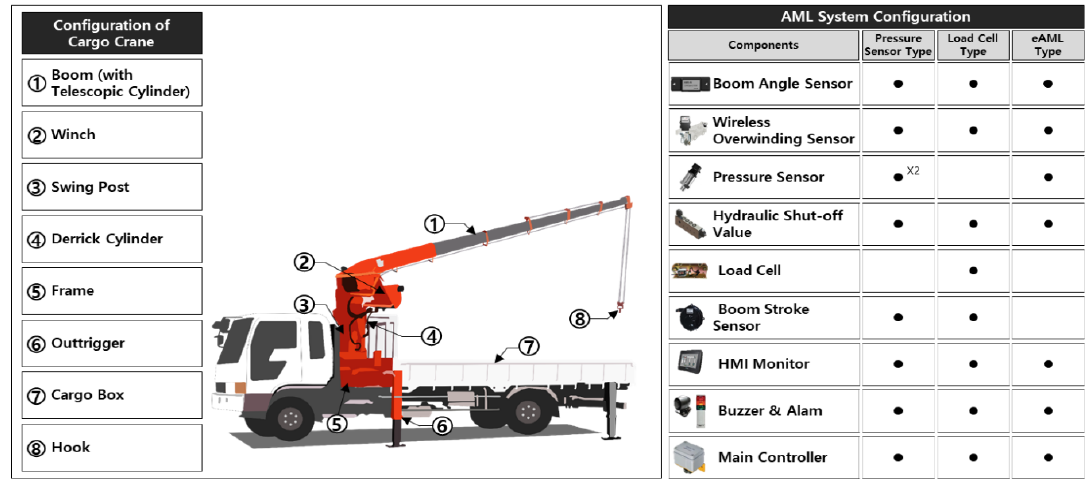
Figure 1. Cargo crane and auto moment limiter (AML) system configurations.